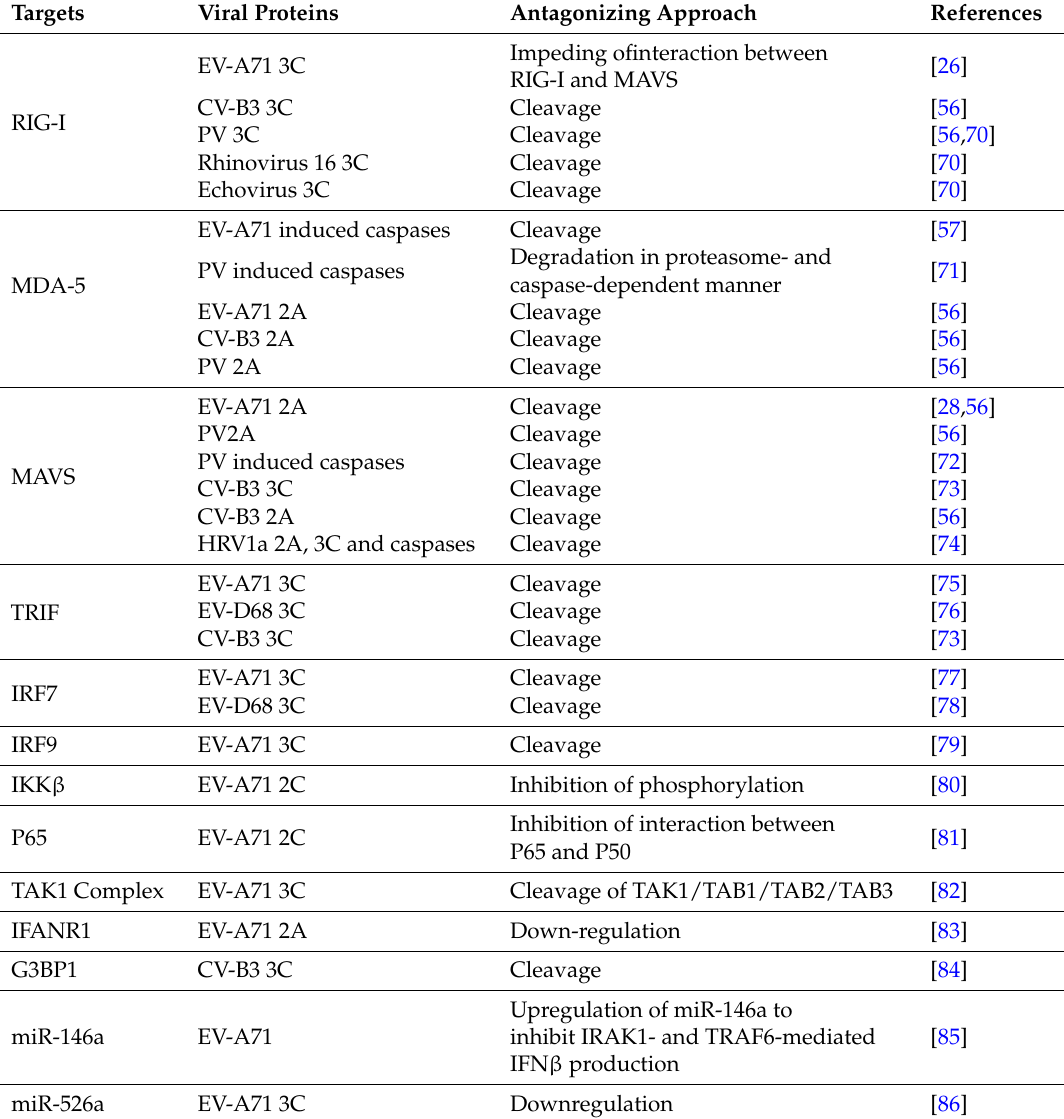
Table 2. Targets of EVs on evading antiviral